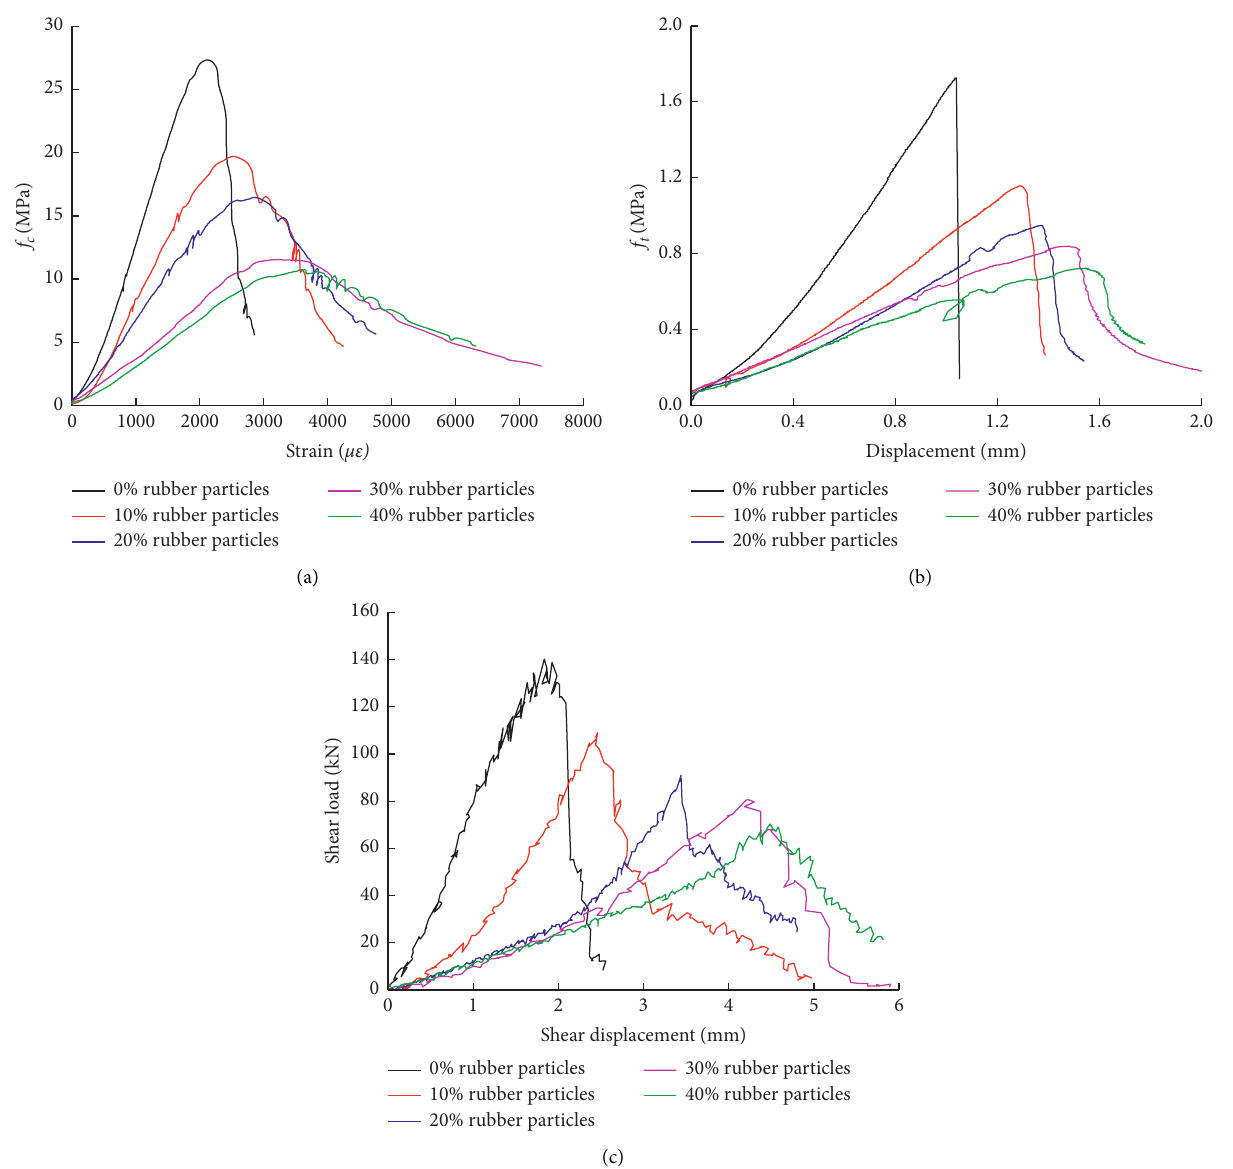
Figure 9: Stress-strain curves of rubber concrete specimens with different substitution rates under uniaxial loading. (a) Uniaxial com- pression, (b) uniaxial splitting, and (c) pure